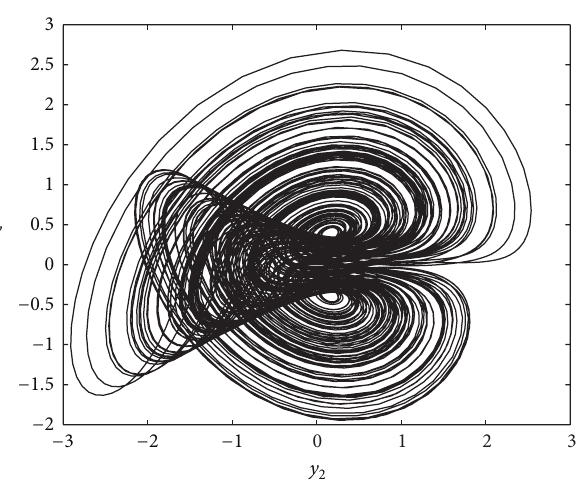
Figure 5: 𝑦 2 - V phase plane, the chaotic attractor.